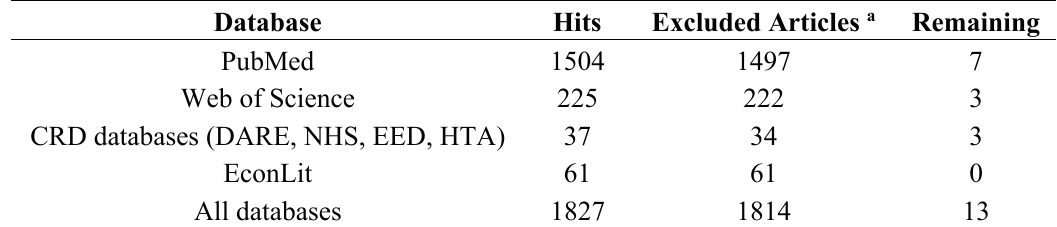
Table 1. Electronic databases searched for economic